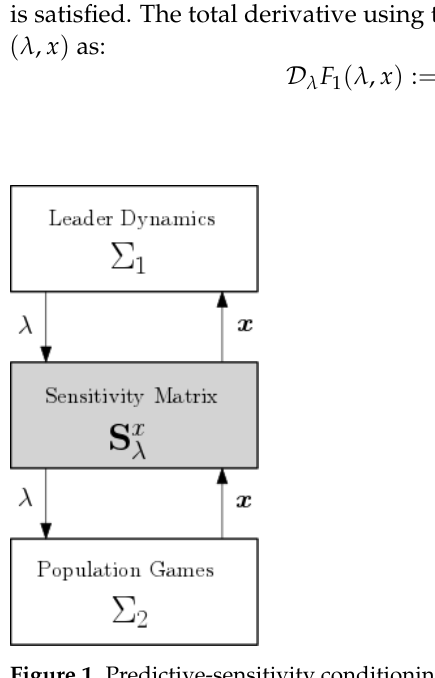
Figure 1. Predictive-sensitivity conditioning